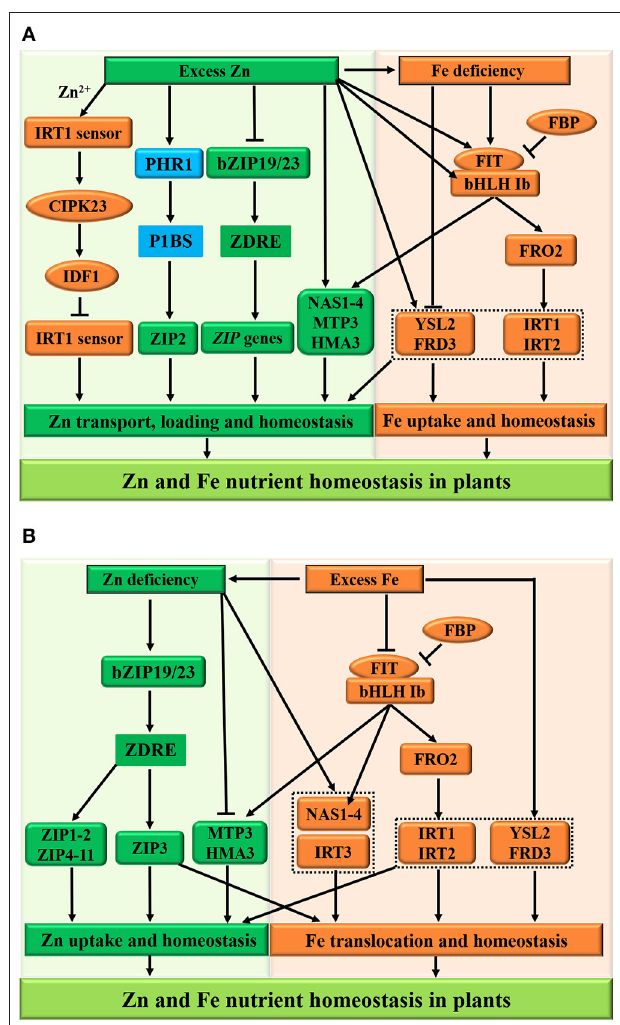
FIGURE 5 | Schematic representation of Zn and Fe homeostasis cross-talk in plants. The excess zinc (Zn) results in the iron (Fe) deficiency (A) , whereas excess Fe reduces the Zn concentration in plants at the physiological level (B) . For the molecular bases of the Zn-Fe homeostasis cross-talk, the FIT protein, ZIP family transporters (ZIP3 and IRT3), and metal tolerance proteins (FRD3, MTP3, and HMA3) function as potential integrators of Zn and Fe nutrient signals in plants. (A) Under excess Zn conditions, the IRT1 acts as a transceptor to sense excess Zn 2 + and orchestrates its own degradation to protect plants from highly reactive Zn 2 + , while the low-Zn-adaptive bZIP19/23 transcription factors are inactivated and inhibit the plant ZIP gene family transporters (such as ZIP5 and ZIP9) to regulate Zn homeostasis. In addition, metal tolerance proteins MTP3 and HMA3 are activated to facilitate Zn loading into xylem. However, the ZIP2 subfamily genes are independent of the bZIP19/23-mediated pathway and are under the control of the PHR1-dependent pathway, resulting in the Zn overaccumulation in plants. Furthermore, the expression of MTP3 and HMA3 is partially dependent on the FIT and contributes to Zn tolerance, while the FIT-independent FRD3 and YSL2 function in Zn and Fe homeostasis, respectively. (B) On the other hand, the deficient Zn-regulated ZIP family (such as ZIP3 and IRT3) and NAS1/4 transporters, contributing to Fe uptake and transport, are induced during Zn deficiency, leading to Fe sufficiency in plants. Consequently, the FBP (FIT-binding protein) inhibits the FIT activity, and the bHLH Ib and FIT transcription factors are repressed in adaptive to Zn deficiency and excess Fe, (Continued)